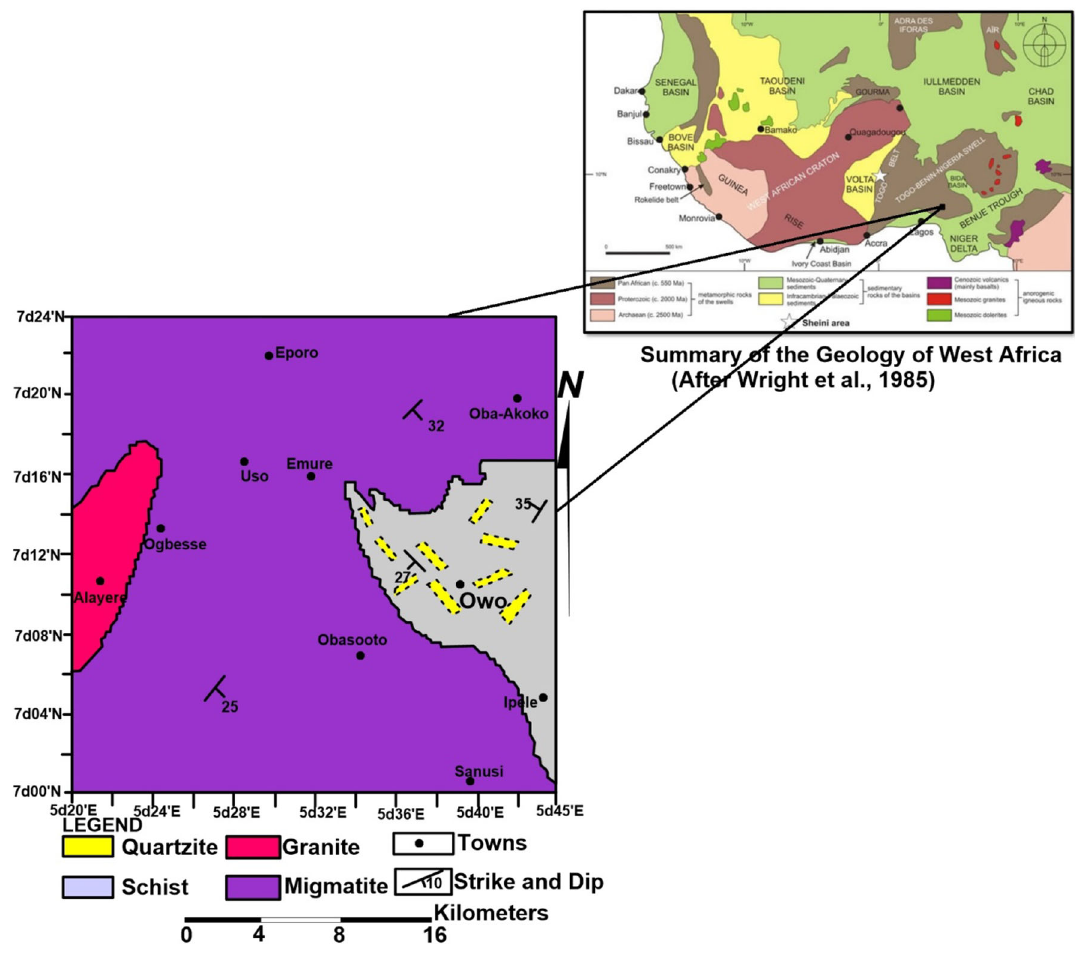
Fig. 2 Geological map of the study